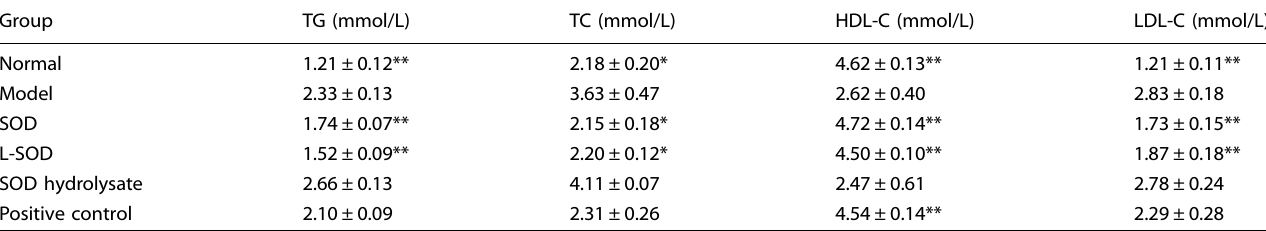
Table 2. Fasting plasma lipid levels after 4-week intervention.